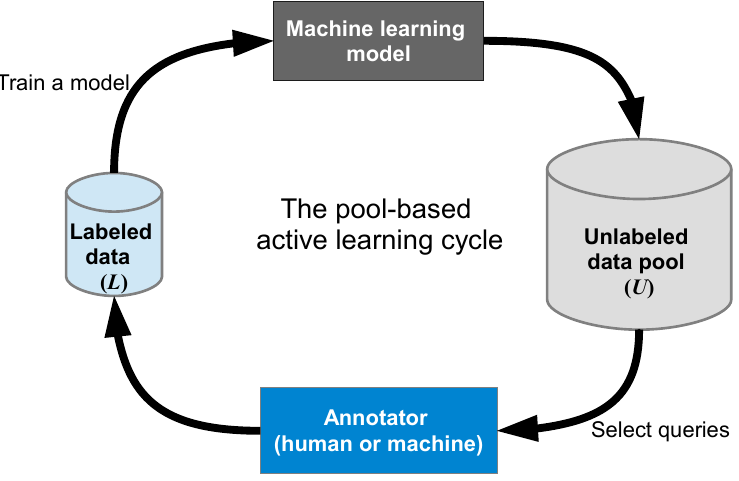
Figure 2. The pool-based active learning cycle (adapted based on